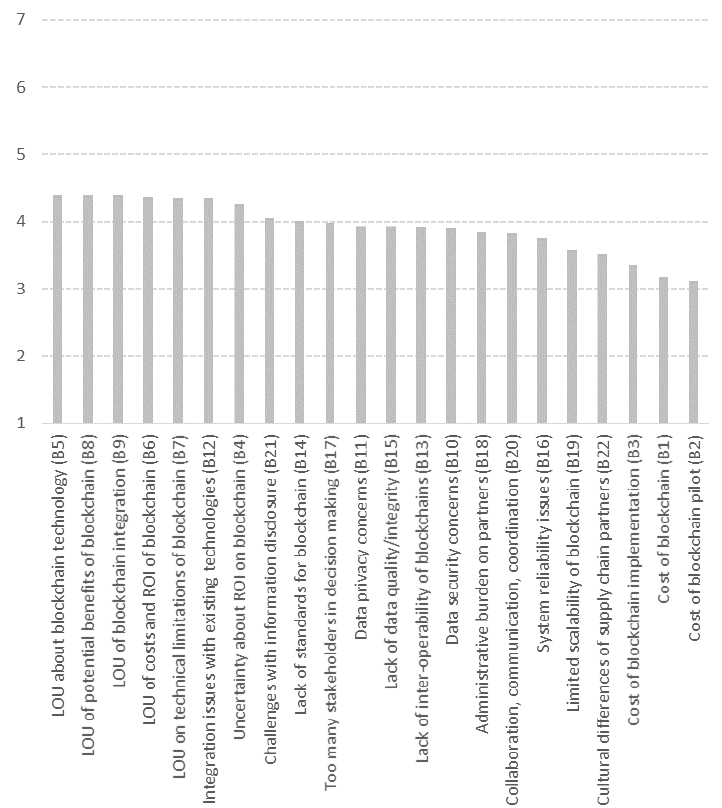
Figure 2. Average assessment of organizational barriers to blockchain adoption ( n = 190; 1 = “not at all”; 7 = “to a very large degree”; LOU: Lack of Understanding).